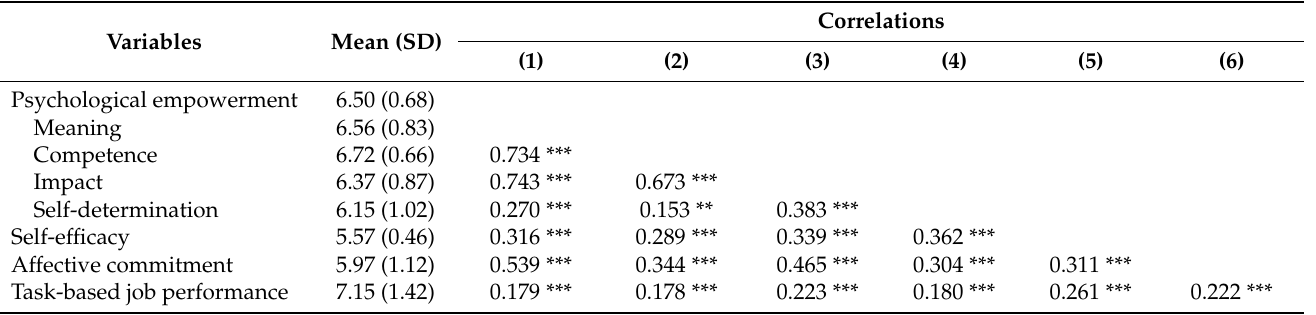
Table 2. Means, standard deviations, and intercorrelation coefficients between variables. Variables Mean (SD)